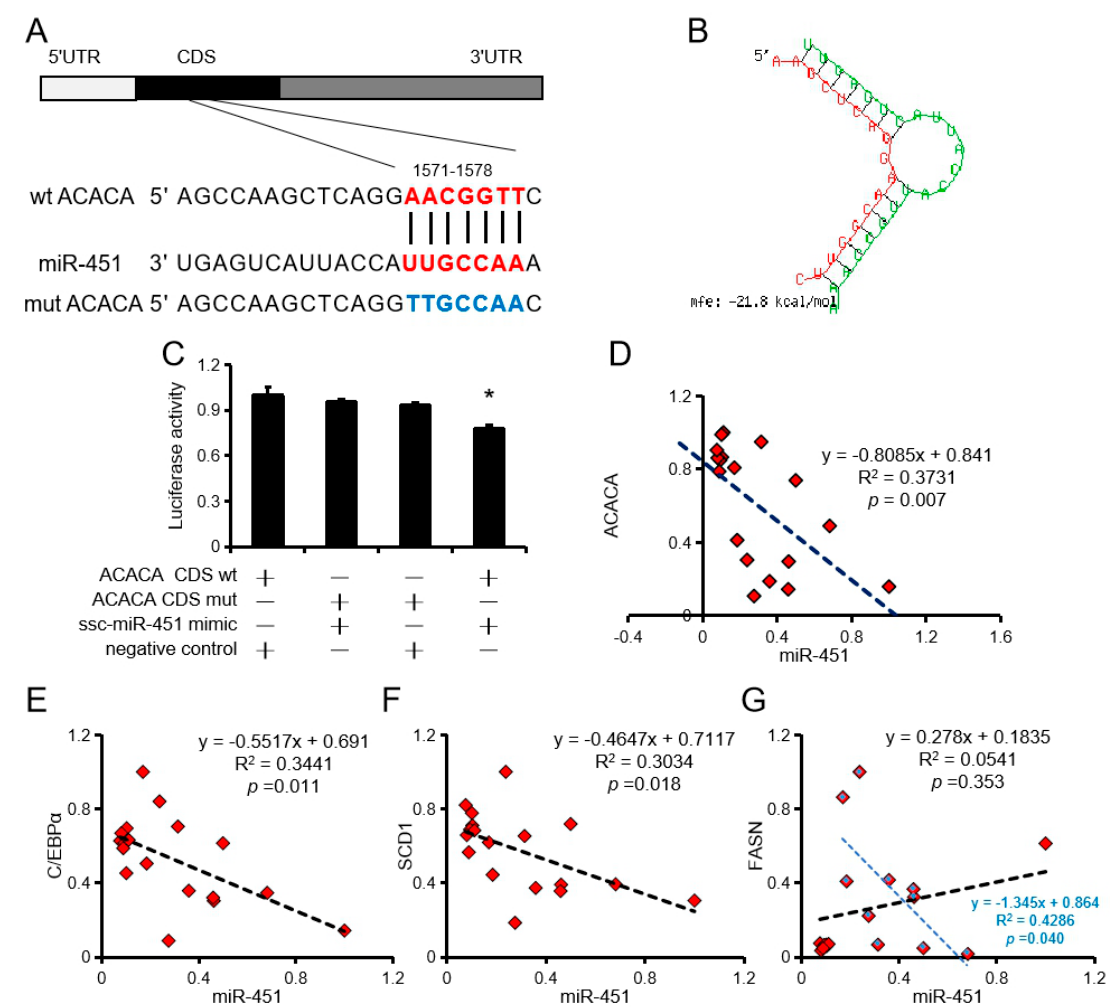
Figure 3. ACACA is a target gene of ssc-miR-451. ( A , B ) Binding site ( A ) and free energy ( B ) of ssc-miR-451 and ACACA. ( C ) Pooled ssc-miR-451 mimic, wt-ACACA CDS, or mut-ACACA CDS was co-transfected with the psiCHECK ™ -2 vector into PK15 cells, and normalized luciferase activity was assayed. n = 3. * p < 0.05. ( D ) Correlation analysis of porcine primary adipocyte ssc-miR-451 and ACACA, n = 18. ( E ) Correlation analysis of porcine primary adipocyte ssc-miR-451 and C / EBP α , n = 18. ( F ) Correlation analysis of porcine primary adipocyte ssc-miR-451 and SCD1, n = 18. ( G ) Correlation analysis of porcine primary adipocyte ssc-miR-451 and FASN, n = 18. The blue mark is the correlation analysis after removing the discrete points, n = 10.